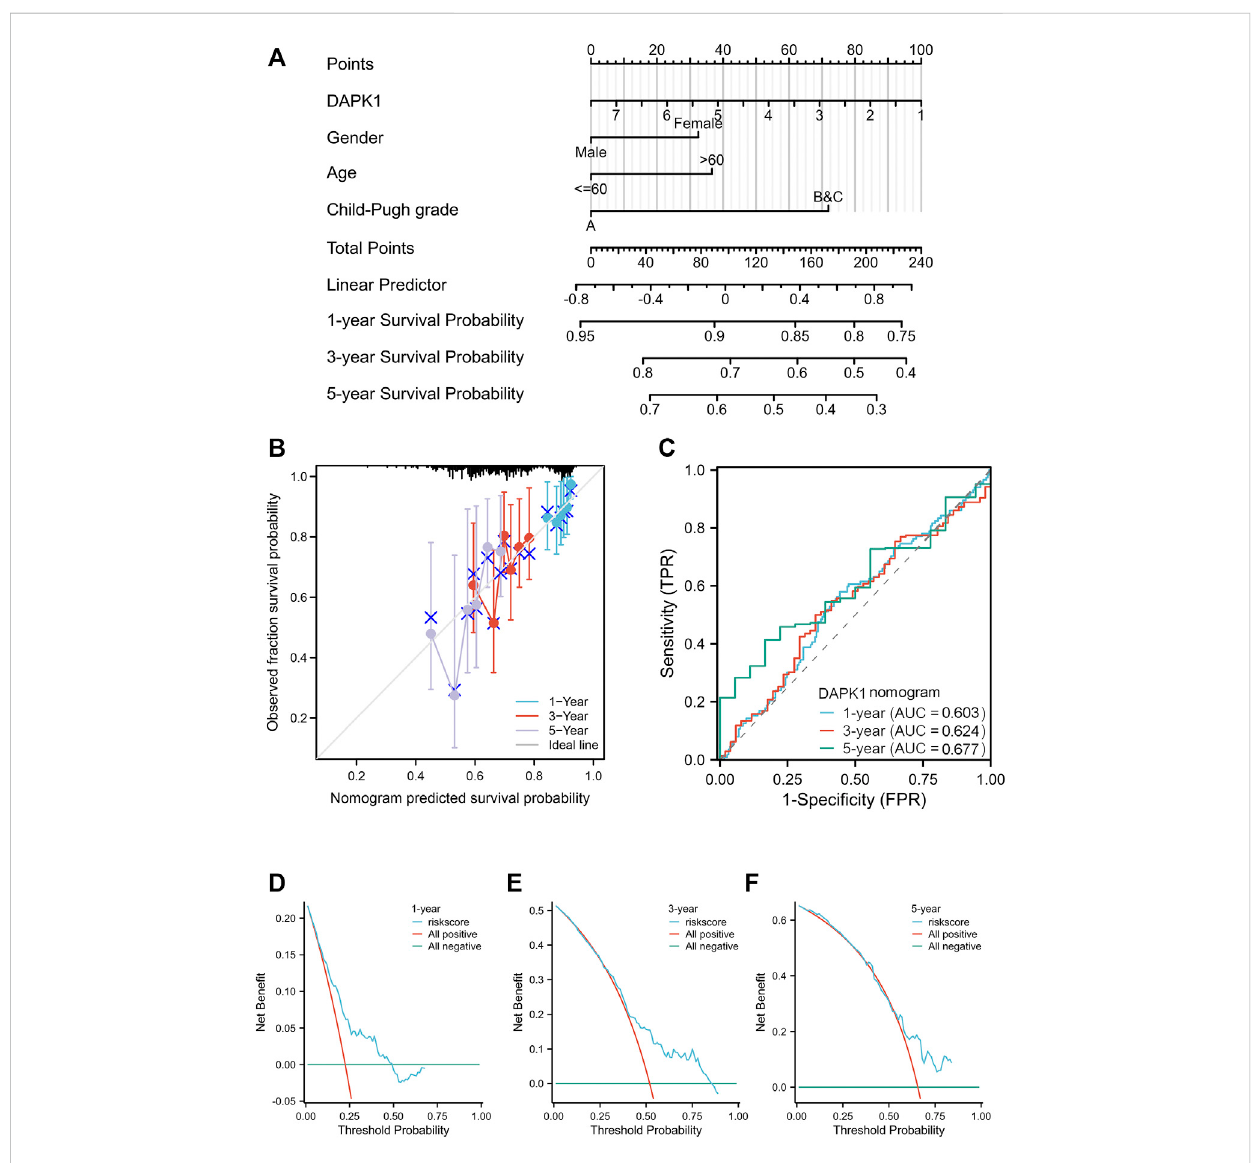
FIGURE 3 The overall survival nomogram model and calibration plots. (A) The overall survival nomogram model to predict the 1, 3, and 5 year OS of HCC patients. (B) Thecalibrationplotsofthenomogrammodel. (C) The1,3,and5 yearROCcurvesofthenomogram. (D – F) The1,3,and5 yearDCAcurvesof the